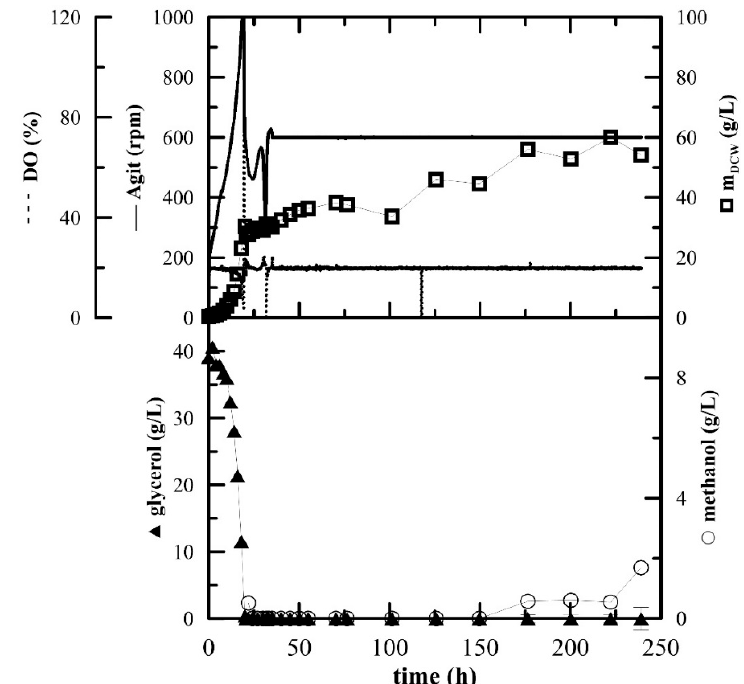
Figure 3. Fed-batch cultivation of P. pastoris expressing rutinosidase with methanol feeding according to the actual level of dissolved oxygen. Conditions: 1.5 L BSM, 5% inoculum, 30 °C, pH 5.0, DO 20%, stirring cascade 50–1000 rpm; after 35 h fixed at 600 rpm.